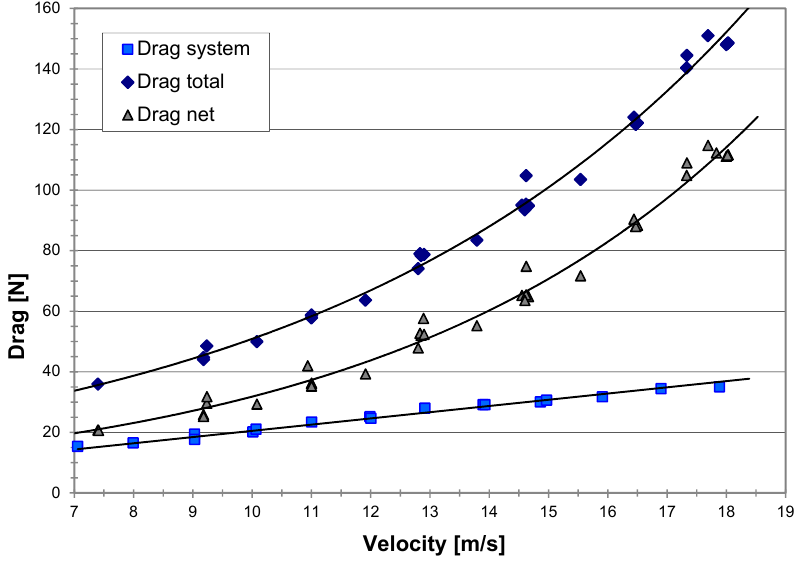
Figure 9. Measured drag of the MRJ vs. velocity; the net drag is that due to the water only.